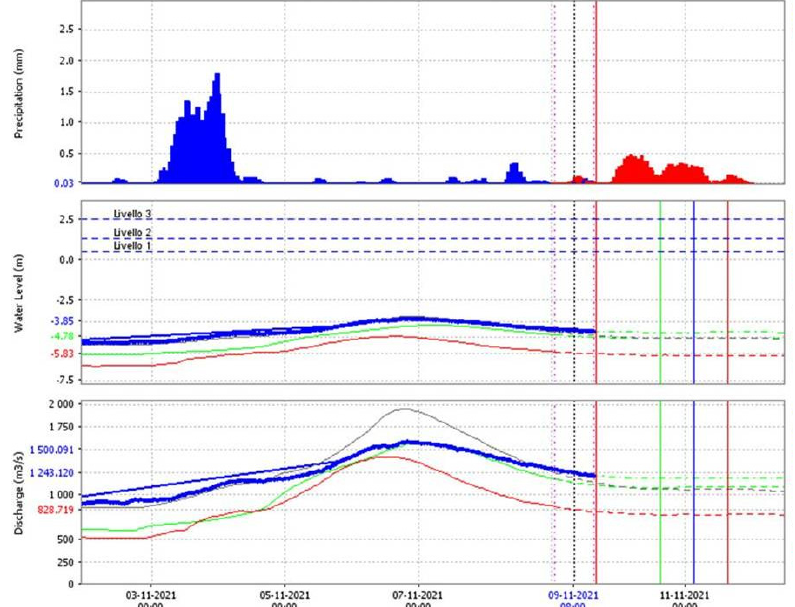
Figure 7. Po River at Pontelagoscuro displayed in FEWS System. Observed (blue histogram) and forecasted (red histogram) mean areal precipitation; observed water level and discharge (solid blue line); simulated historical water level and discharge (grey, green and red solid lines); forecasted water level and discharge (grey, green and red dotted lines).